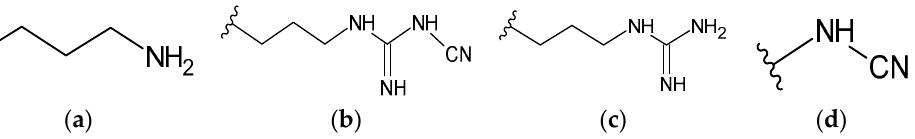
Figure 3. Terminal groups that may occur in poly(hexamethylene biguanide) (PHMB) chains. ( a ) Amino; ( b ) cyanoguanidino; ( c ) guanidino; and ( d ) cyanoamino.